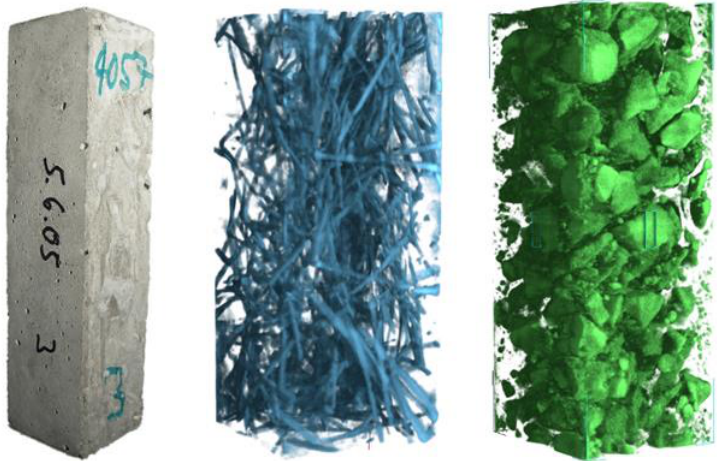
Figure 9. Tomography data of a steel reinforced concrete sample ( left ) (3 cm × 3 cm × 15 cm) ob- tained with X-rays ( middle ) and thermal neutrons ( right ).